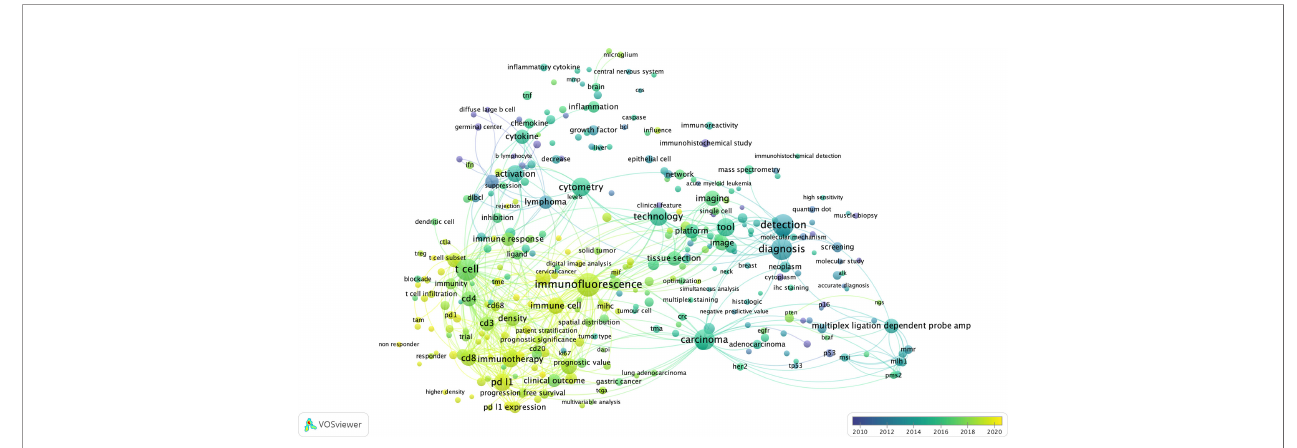
FIGURE 3 | The bibliometric map of multiplexed IHC over the years. Using VOS Viewer, a software tool for constructing and visualizing the bibliometric network related to “ multiplexed immunohistochemistry ” on PUBMED (see Methods ), we observed a shift from 2010 where technology development started (blue circles), to its use to unravel complex cellular networks in 2020 (yellow areas) with a strong focus on immuno-oncology and T-cell